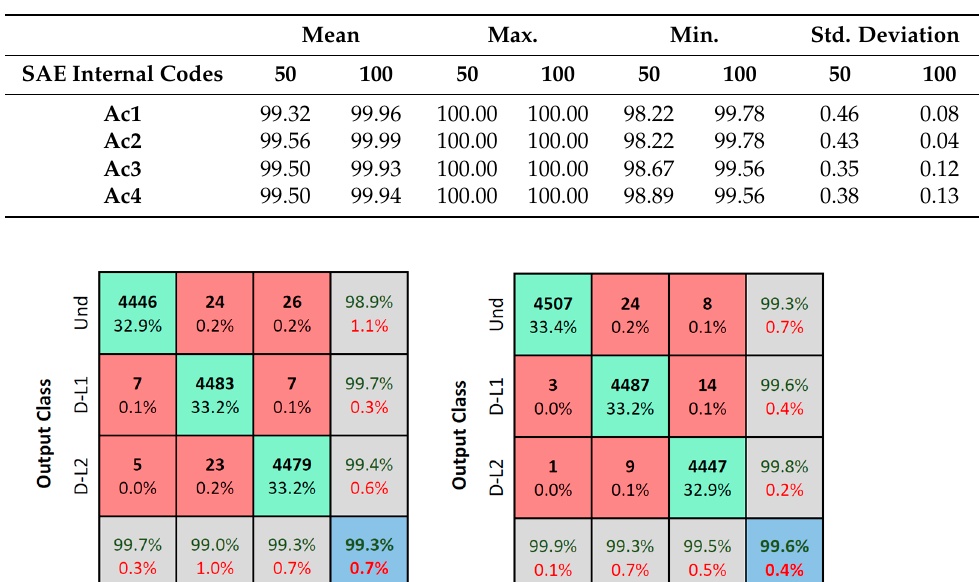
Table 3. Simply supported numerical beam: correct classification rates in percentage.